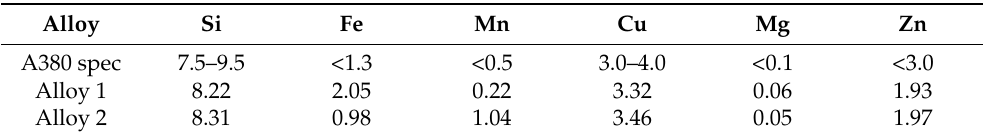
Table 2. Typical composition (wt.%) spec. of A380 alloy and two variations used to simulate Fe and Mn